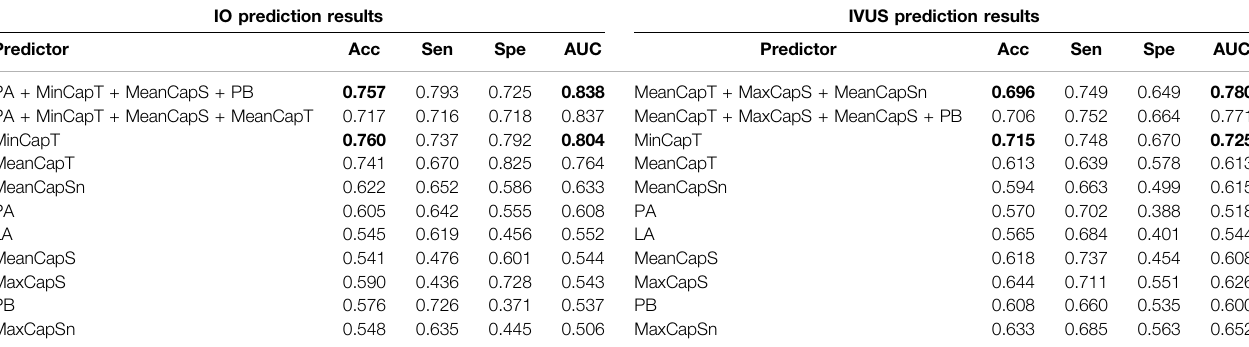
TABLE 6 | Δ MinCapT prediction results using the LSSVM method. AUC: area under the ROC curve; Acc: accuracy; Sen: sensitivity; Spe: speci fi city. Bold indicates the best value. IO prediction